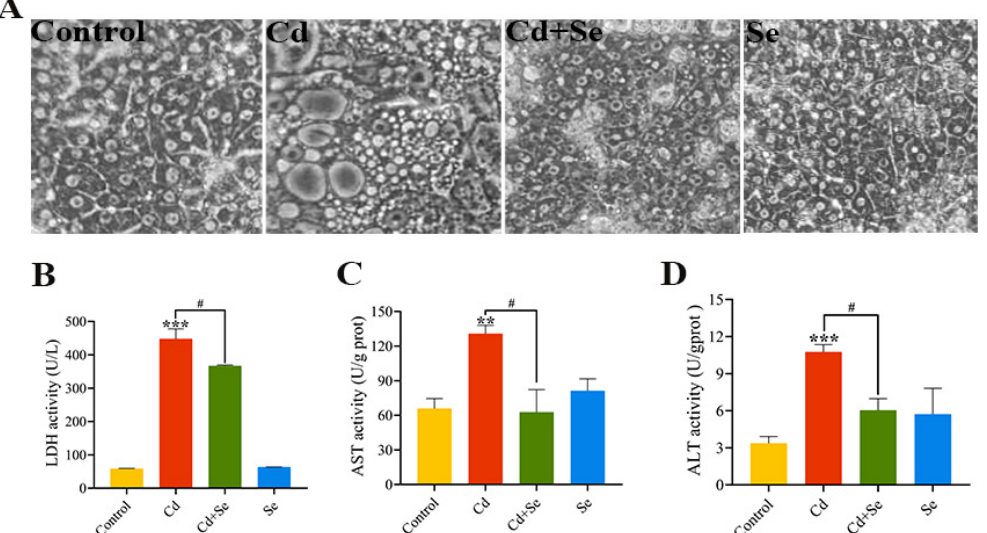
Figure 2 . Se attenuates Cd-induced hepatocytes trauma. ( A ) The status of hepatocytes (400×); ( B ) lactate dehydrogenase (LDH) activity; ( C ) Aspartate aminotransferase (AST) activity; ( D ) Alanine aminotransferase (ALT) activity. The data are expressed as mean ± SD. “Asterisk” indicates a significant difference compared with control group (** p < 0.01 and *** p < 0.001). “ # ” indicates a significant difference between Cd group ( # p < 0.05).